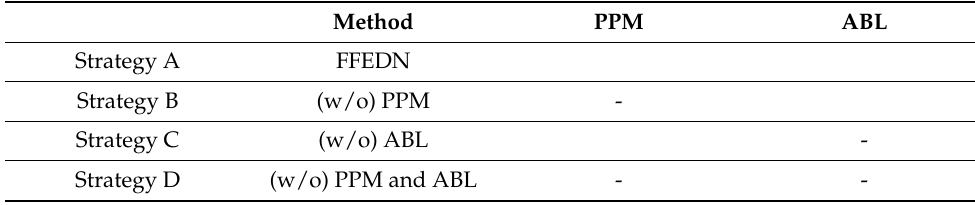
Table 10. Different strategies for the ablation